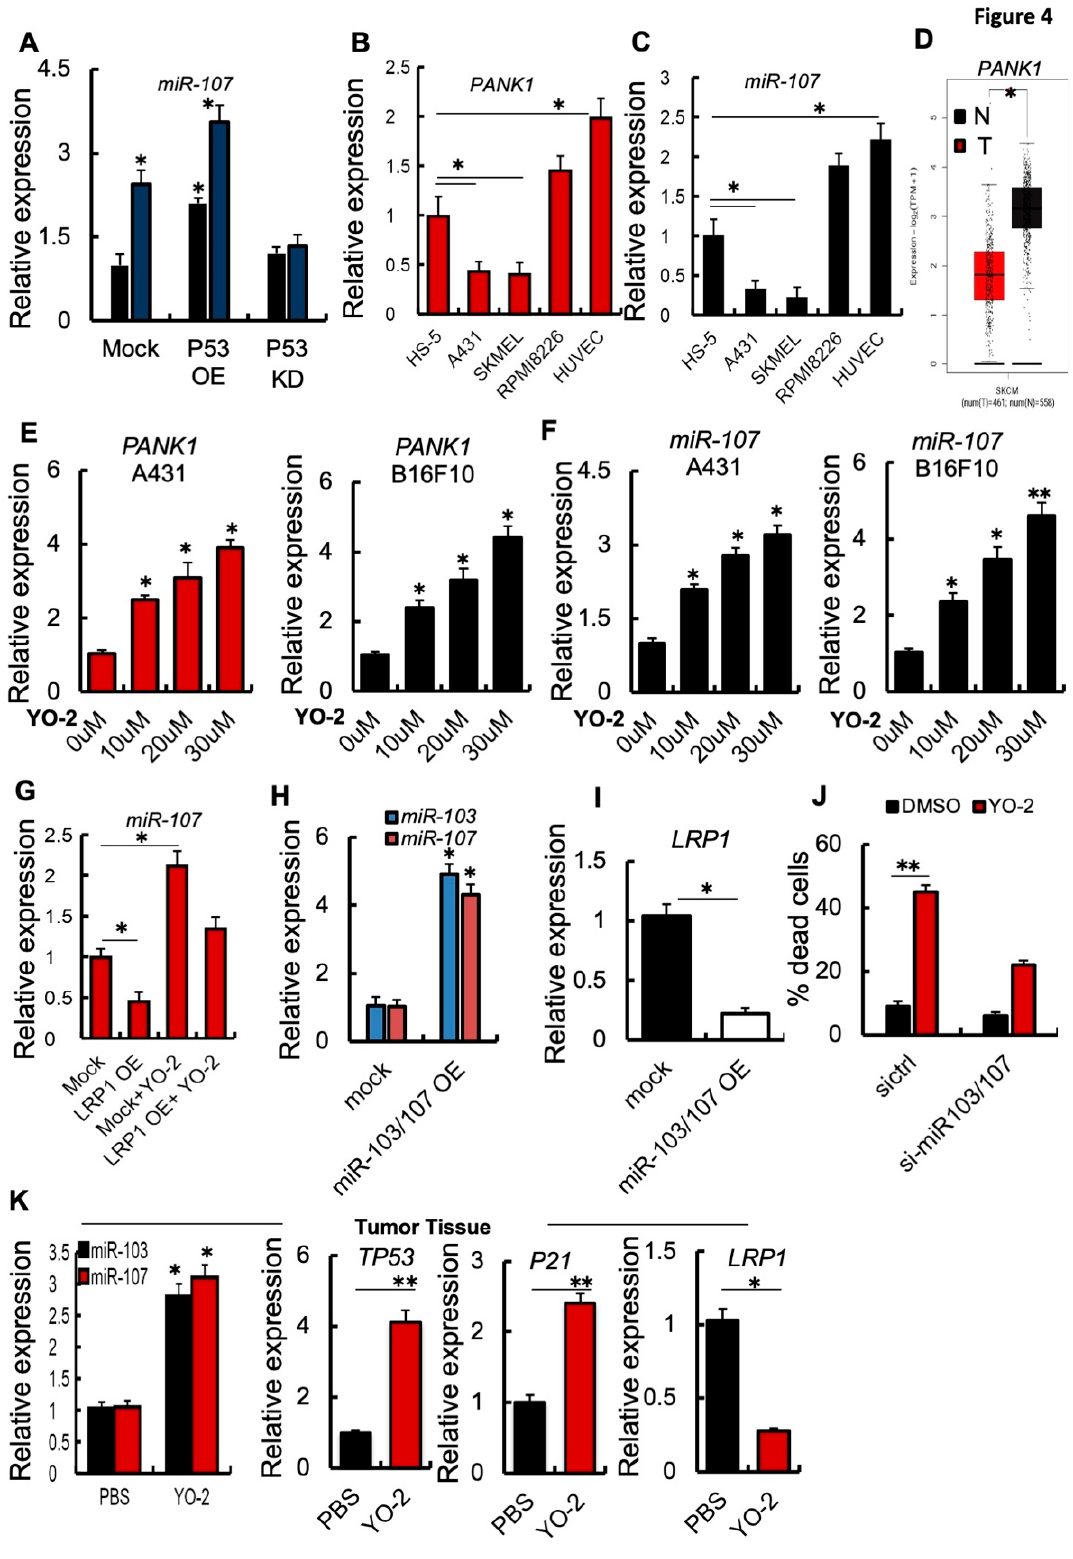
Figure 4. YO ‐ 2 restores tumor suppressor miR ‐ 107/103 expression. ( A ) Fold change in miR ‐ 107 ex ‐ Figure 4. YO-2 restores tumor suppressor miR-107/103 expression. ( A ) Fold change in miR-107 pression in P53 OE and P53 KD murine B16F10 cells treated with/without 10 uM/mL YO ‐ 2 following expression in P53 OE and P53 KD murine B16F10 cells treated with/without 10 µ M/mL YO-2 a 24 h culture period. In addition, expressions were compared to untreated Mock controls. ( B , C ) Fold change in human PANK1 and miR ‐ 107 expression in HS ‐ 5, A431, SK ‐ MEL ‐ 28, and HUVEC cells. The expression was compared to the expression in HS ‐ 5 cells ( n = 3/cell line). ( D ) Human PANK1 expression levels in tumors (T) and adjacent normal tissues (N) derived from SKCM pa ‐ tients. Data were retrieved from the TCGA database and analyzed by Timer ( p < 0.05). ( E , F ) Human A431 and murine B16F10 cells were cultured with or without indicated concentration of YO ‐ 2 for 24 h. Fold change in human and mouse PANK1 ( E ) or miR ‐ 107 ( F ). Expressions were compared to ex ‐ pression in untreated control cells. ( G ) Fold change in miR ‐ 107 expression determined by qPCR in mock or LRP1 OE cells treated with/without YO ‐ 2 ( n = 3/group). The expression was compared to